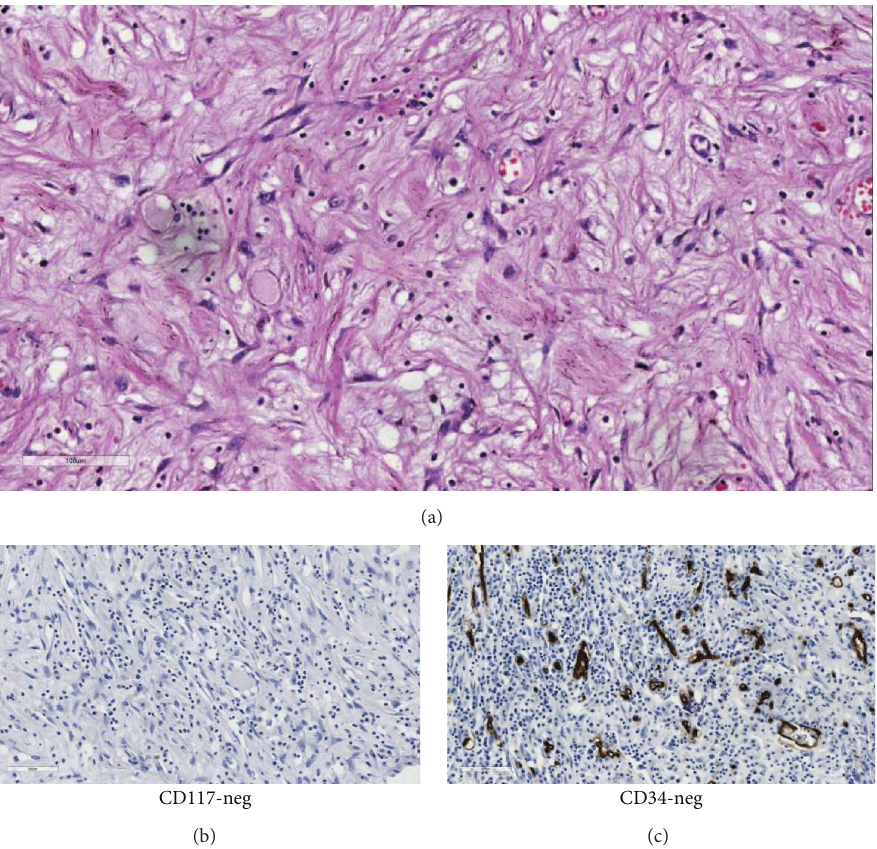
Figure 3: (a) Microscopic appearance of IFP (Eosin/Hematoxylin stain). (b) Immunohistochemical staining negative for CD34. (c) Immunohistochemical staining negative for